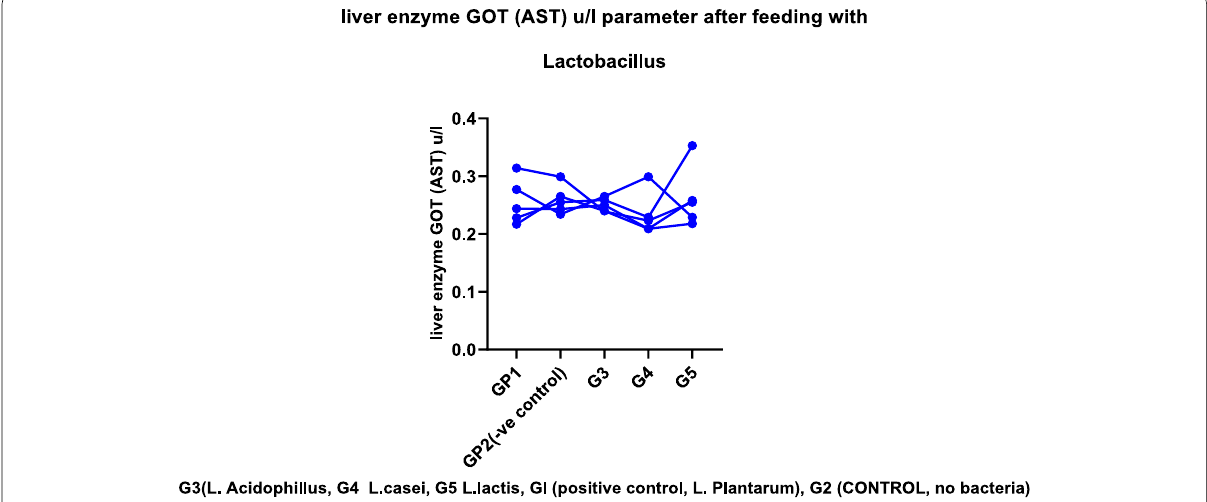
Table 5 Liver enzymes GPT (ALT) u/l parameter before feeding with Lactobacillus spp. Group